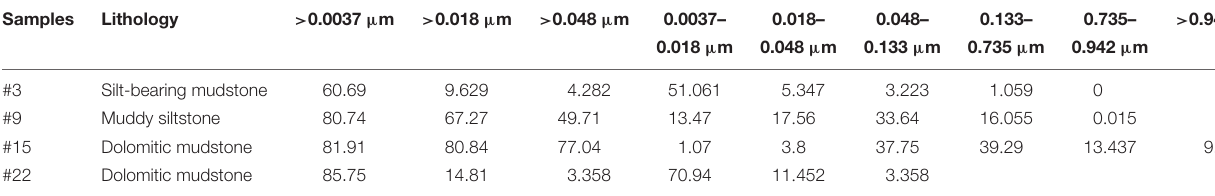
TABLE A4 | High-pressure mercury injection